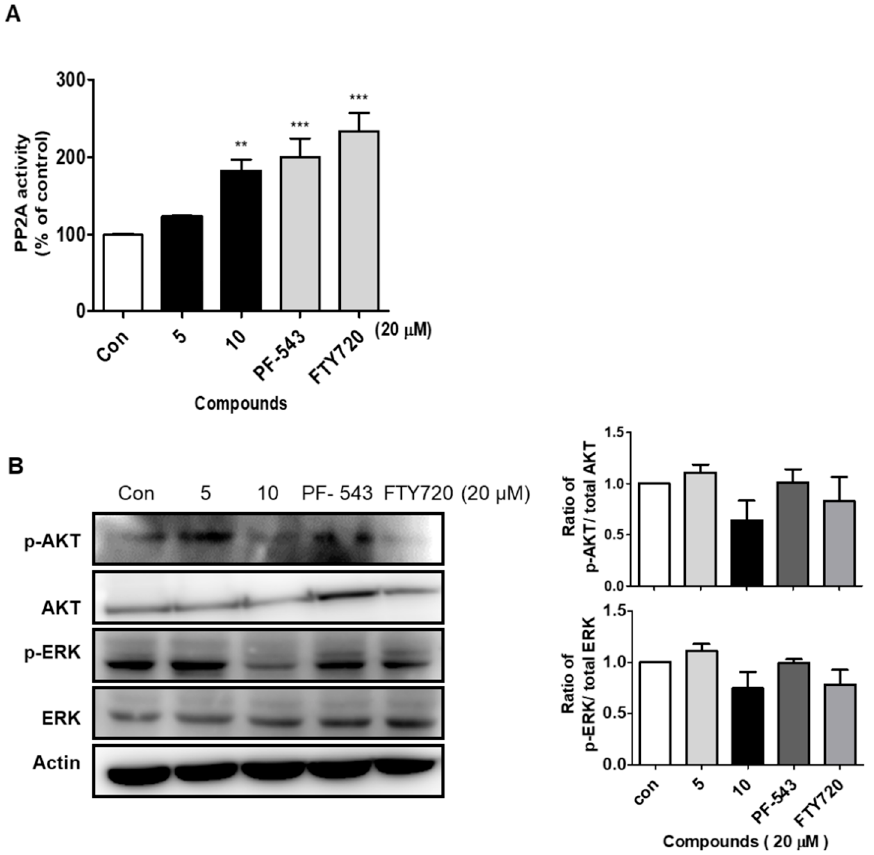
Figure 5. ( A ) PP2A activity of compounds 5 , 10 , PF-543, and FTY720 (20 µM) in MIA PaCa2 cells. ( B ) MIA PaCa2 cells were treated with compounds 5 , 10 , PF-543, and FTY720 (20 µM) for 24 h, then